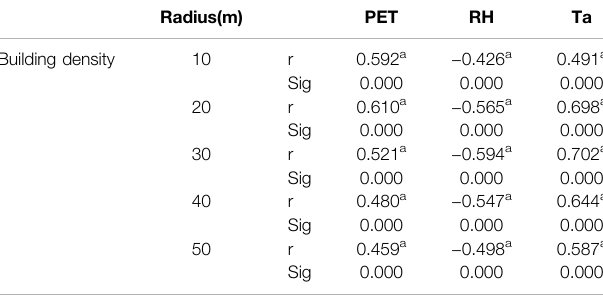
TABLE 6 | Correlation coef fi cients between building density and simulated data within different buffer radiuses. PET RH Ta